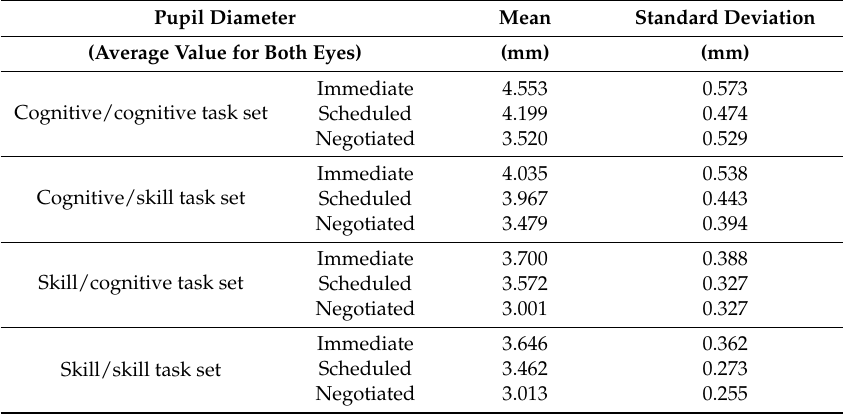
Table 3. Descriptive statistics of pupil diameters under each task